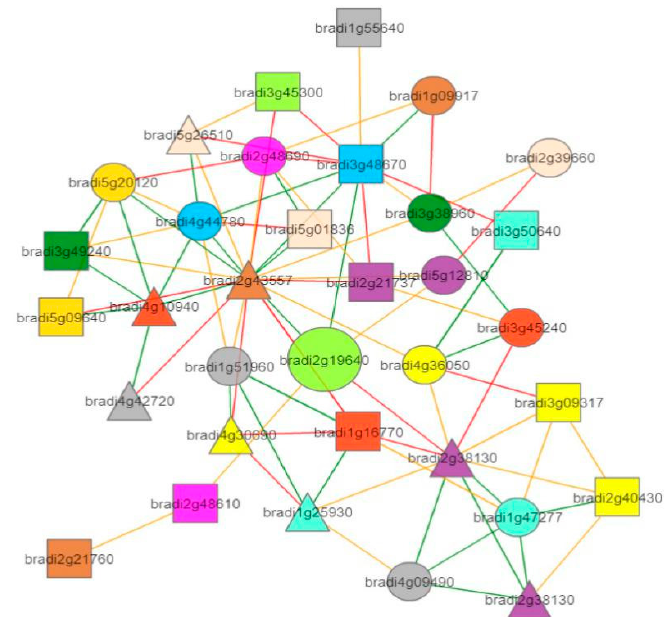
Figure 7. Co-expression neighborhood of PsaN (take BdTPS1 for example, large light green circle). The straight lines of different colors show how strongly two genes are co-expressed, with green, yellow, and red edges indicating strong, medium, and weak co-expression, respectively.